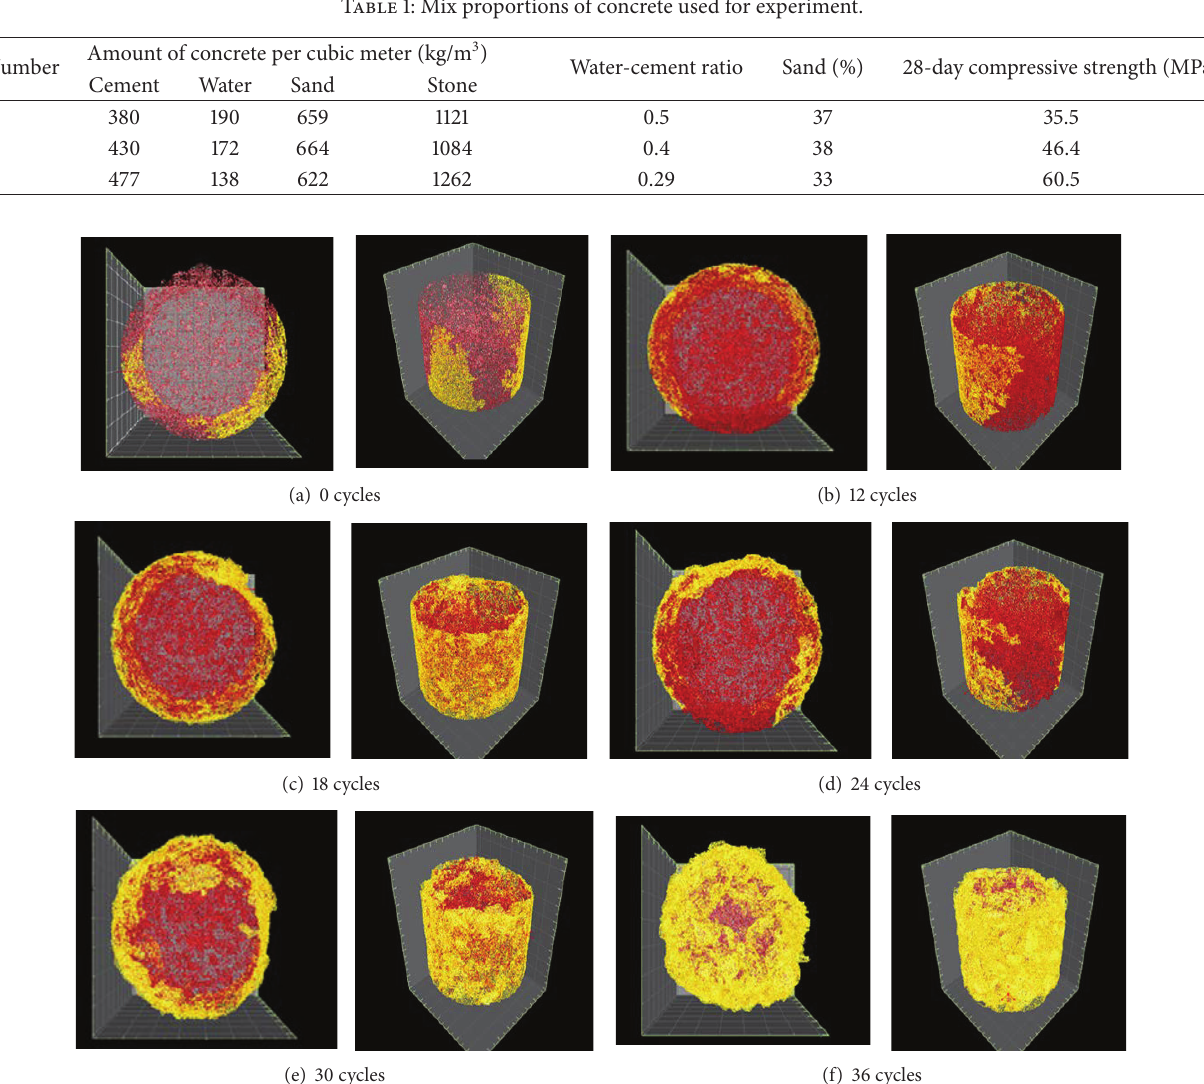
Table 1: Mix proportions of concrete used for experiment.